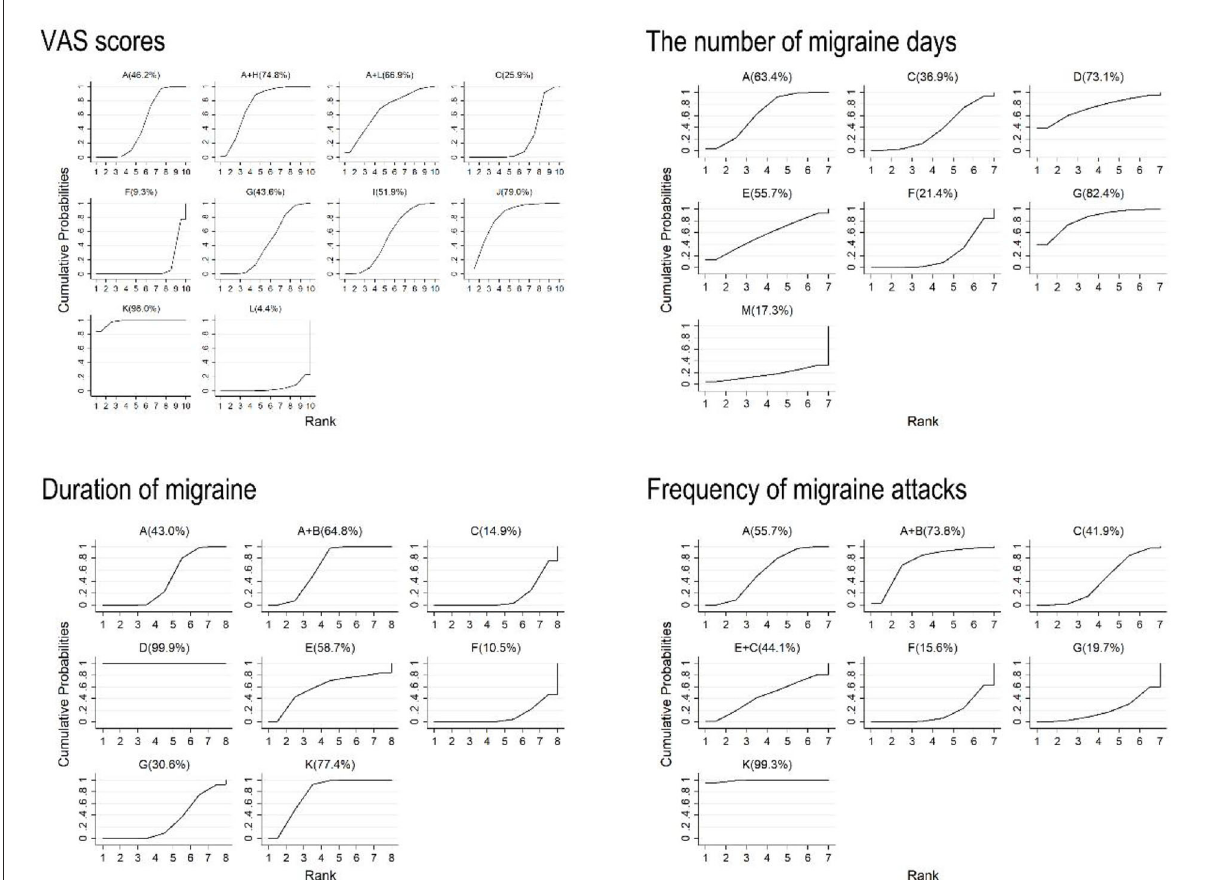
FIGURE6 Surface under the cumulative ranking curves of VAS scores, the number of migraine days, duration of migraine, and frequency of migraine attacks. A, conventional acupuncture; B, massage; C, analgesic; D, embedding needle therapy; E, acupressure; F, placebo; G, electroacupuncture; H, cupping; I, auricular acupuncture; J, acupoint implantation; K, acupoint injection; L, traditional Chinese medicine; and M, laser